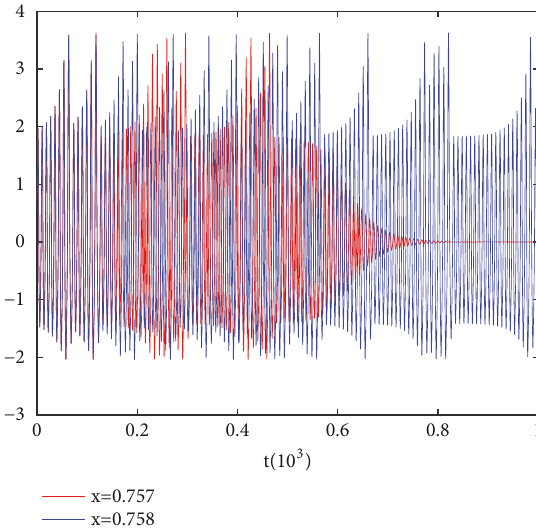
Figure 5: Sensitive dependence of the dynamical system (1) on initial conditions.